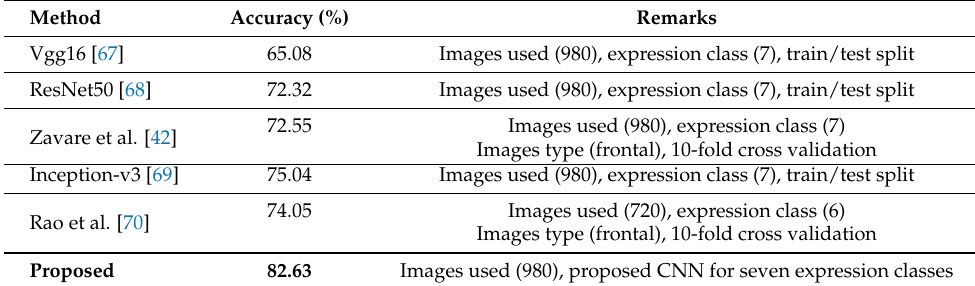
Figure 15. Confusion matrix for the ( a ) KDEF, ( b ) GENKI, ( c ) CK+, and ( d ) SFEW dataset after the product-rule-based fusion performance of the proposed FERS. Table 7. Performance comparison of the proposed FERS for the KDEF database.